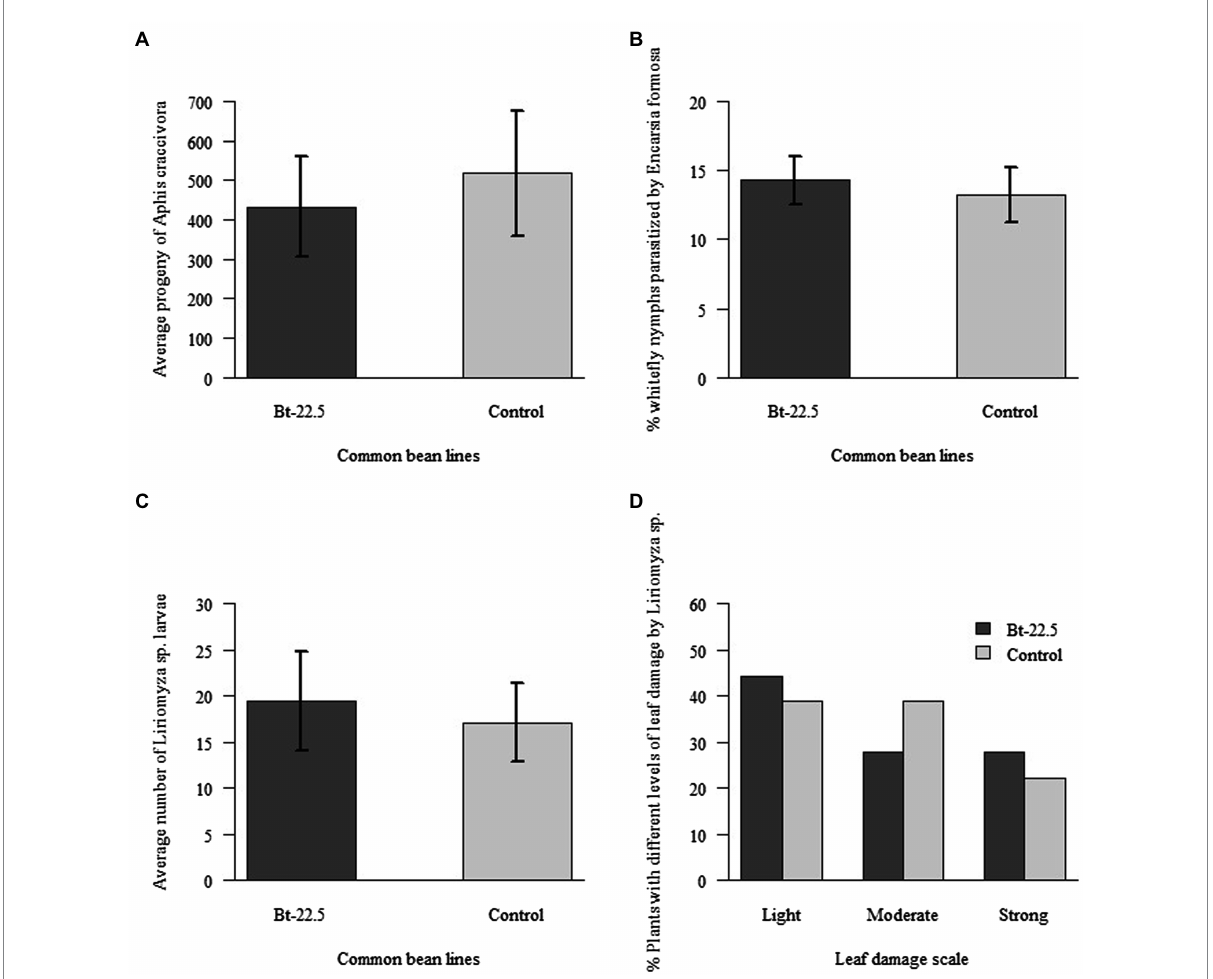
FIGURE 7 Development of non-target insects on plants of the transgenic common bean line Bt-22.5 expressing an RNAi construct for the silencing of the whitefly Bemisia tabaci vATPase gene, compared to the non-transgenic control: (A) Average progeny of the black aphid Aphis craccivora ( n = 3); (B) Average percent of whitefly nymphs parasitized by Encarsia formosa ( n = 3). (C) Average number of larvae of the leafminer Liriomyza sp. ( n = 18); (D) Percent of plants with different levels of leaf damage from Liriomyza